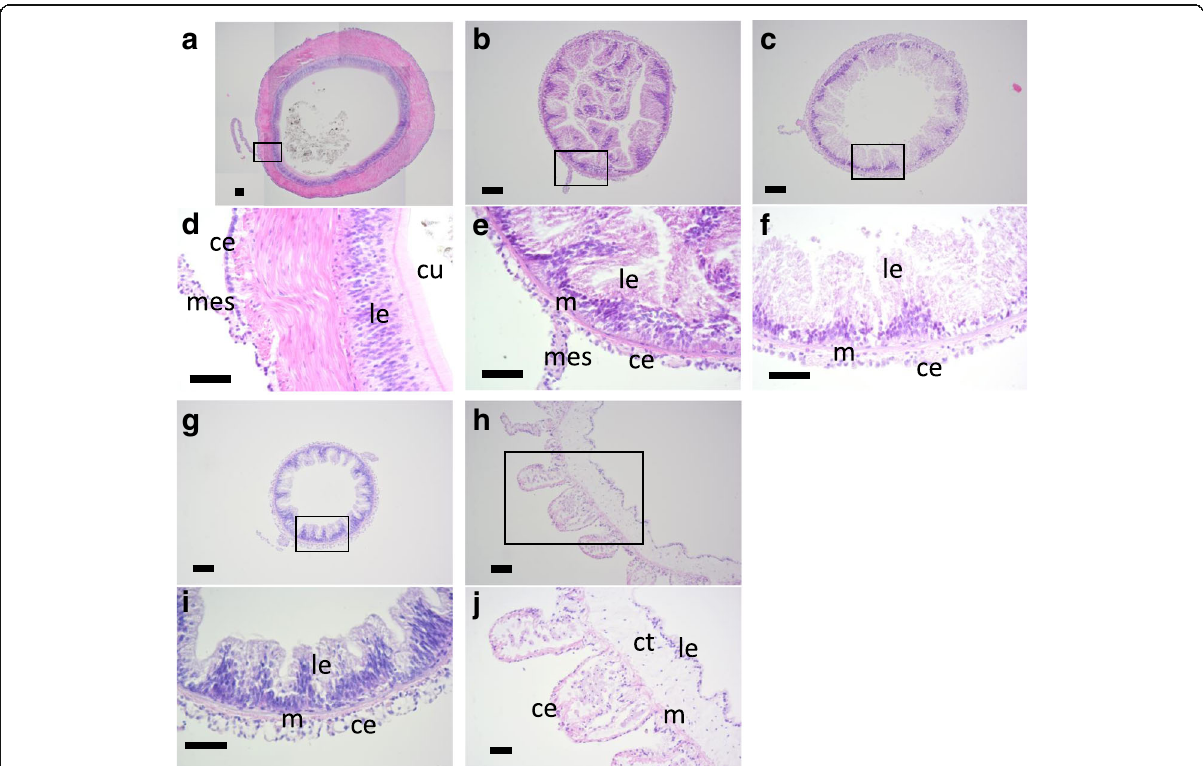
Fig. 4 Histology of the intact digestive tract. Cross sections of the digestive tract of E. quinquesemita were stained with HE. d , e , f , i , j are high- magnification views of the boxed areas in a , b , c , g , h , respectively. a , d Stomach. Some contents of the stomach are also observed in a . b , e 1st descending intestine. c , f Ascending intestine. g , i 2nd descending intestine. h , j Cloaca. ce, celomic epithelium; ct, connective tissue; cu, cuticle; gd, gonadal duct; le, luminal epithelium; m, muscle; mes, mesentery. Scale bars100 μ m in a - c , g , h ; 50 μ m in d - f , i ,